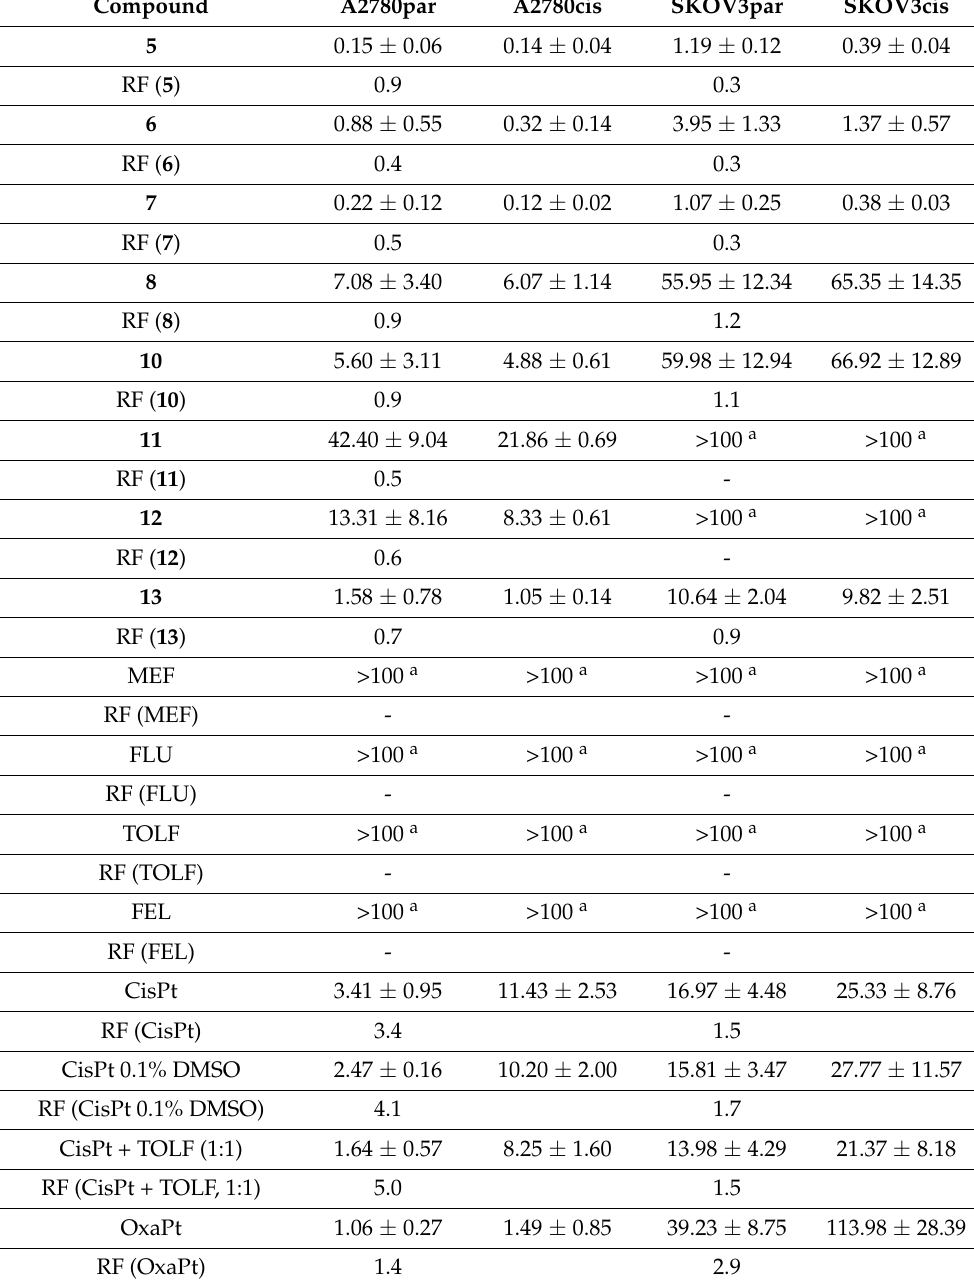
Table 1. Cytotoxicity values (IC 50 ) of tested platinum(IV) complexes and NSAIDs in µ M compared to cisplatin and oxaliplatin (MTT assay, 48 h exposure, mean +/ − standard deviation of 3 replicates). Resistant factors (RF) were calculated for all compounds as a ratio of IC 50 value resistant cell line and IC 50 value parental cell line. OxaPt: oxaliplatin; CisPt: cisplatin. Compound